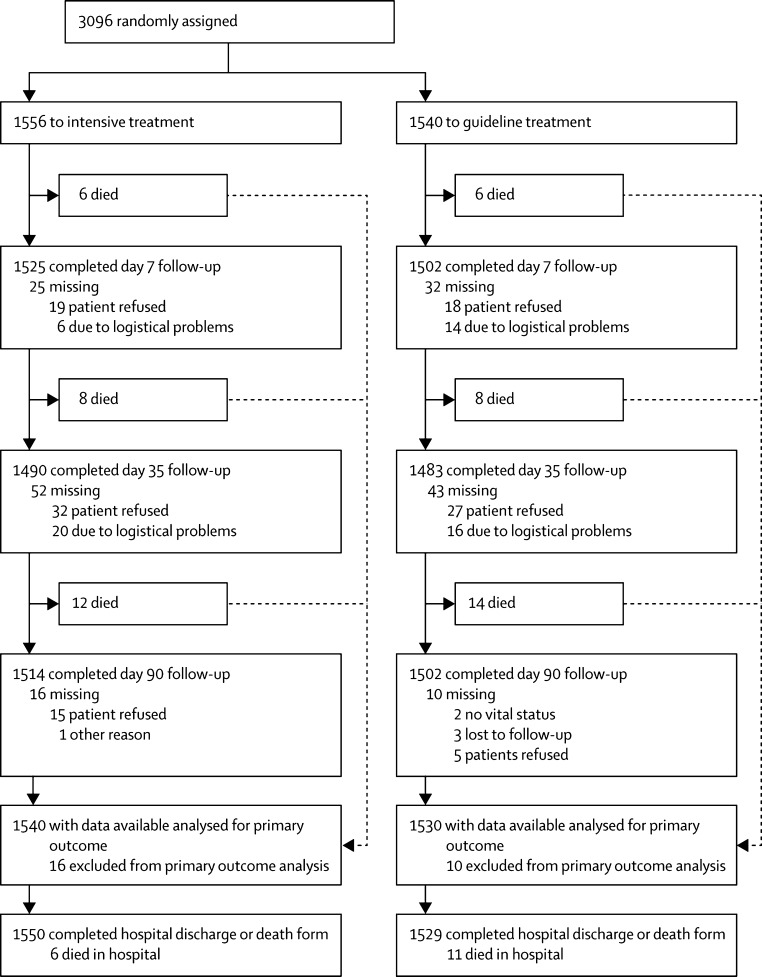
Study flowScreening for eligibility was not collected routinely.